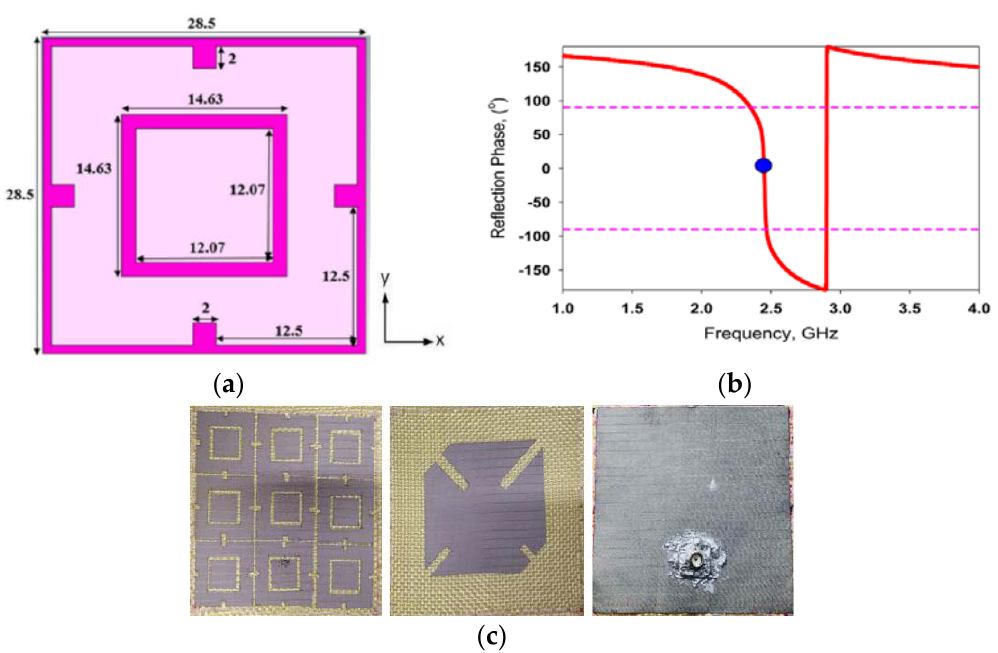
Figure 10. A dual-band wearable textile antenna [101]. ( a ) AMC unit cell dimensions of the AMC unit cell (in mm), ( b ) reflection phase of the AMC unit cell, and ( c ) fabricated prototype of the antenna.